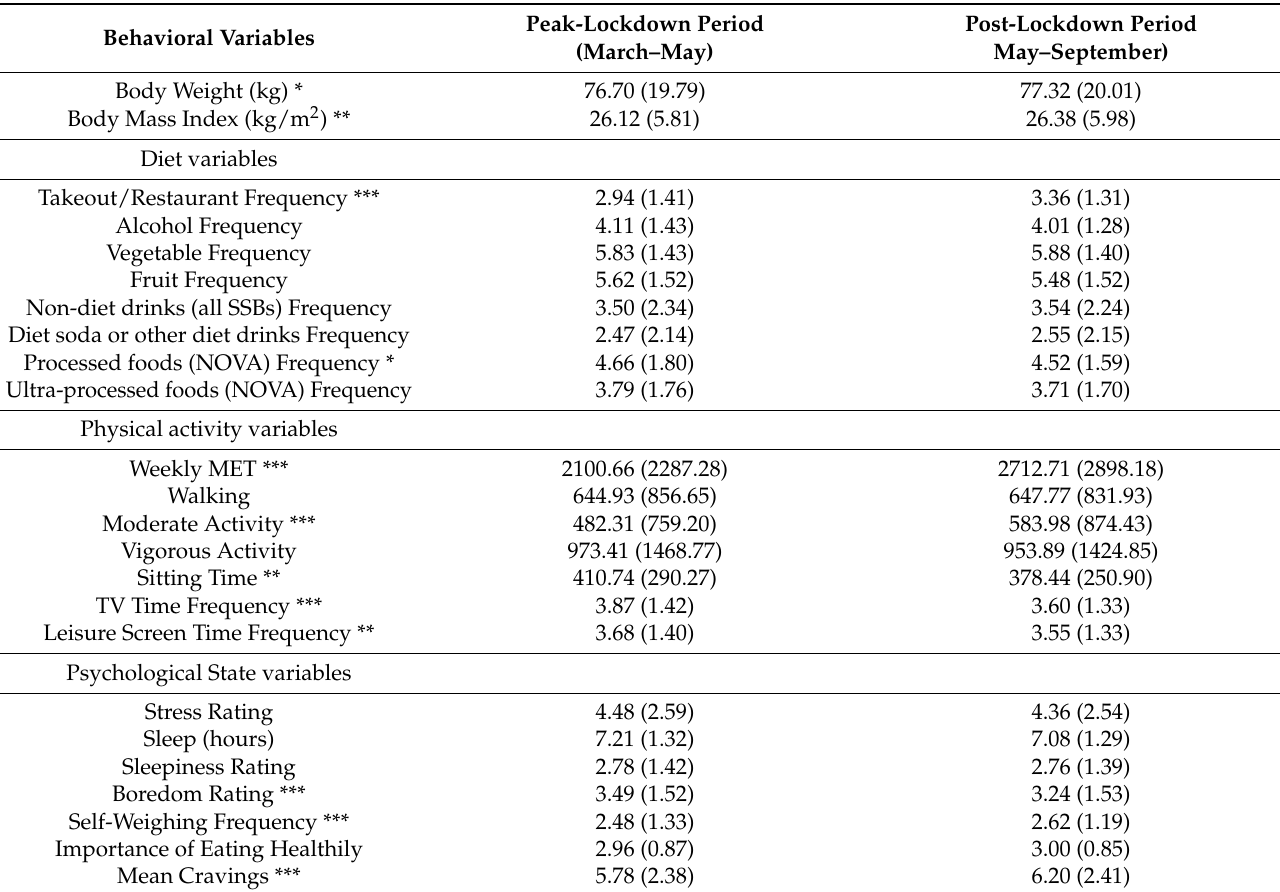
Table 1. Self-reported changes in behaviors during the peak-lockdown period and at 5-month follow-up during the post-lockdown